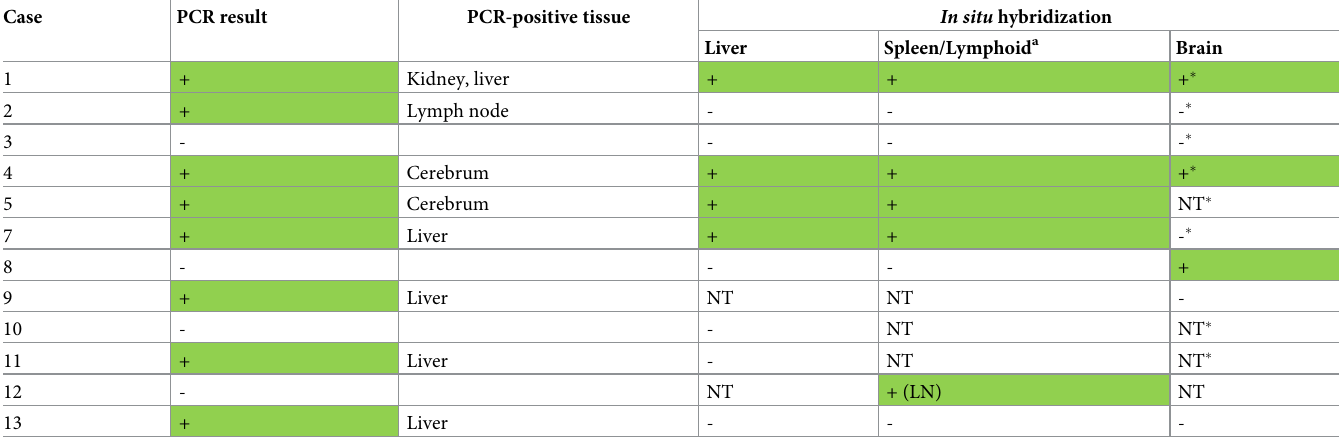
Table 4. Summary of circovirus in situ hybridization testing and